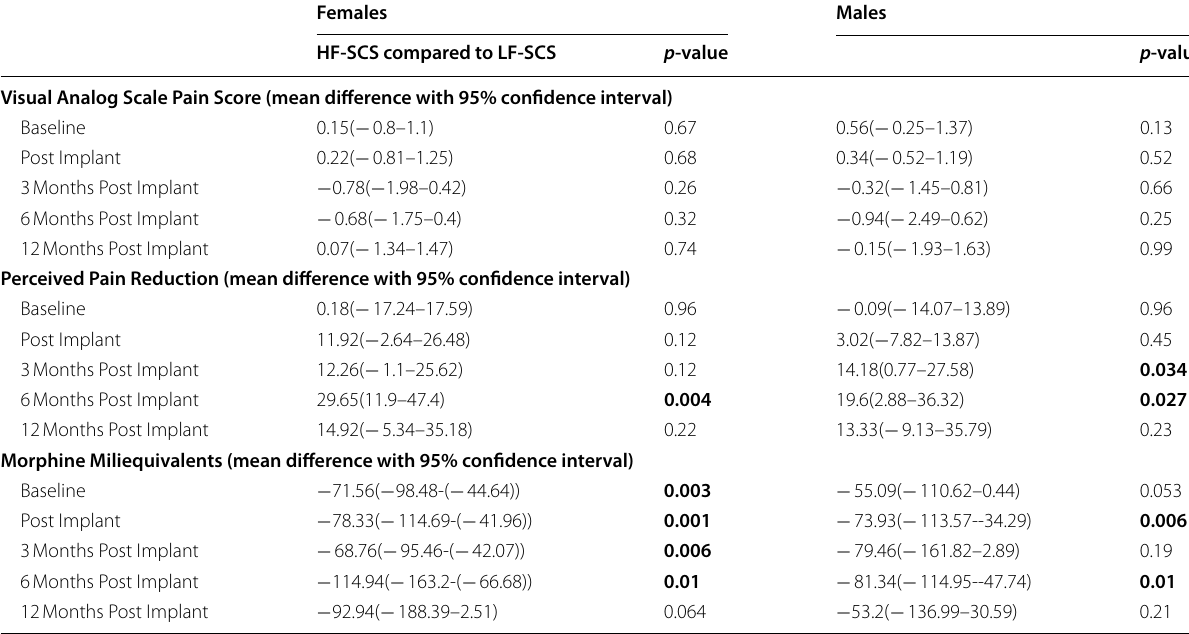
Table 6 Comparison of high frequency and low frequency spinal cord stimulator mean differences and 95% confidence intervals at each time point for visual analog scale pain scores, perceived pain reduction and opioid use according to sex. For mean differences, the confidence interval is considered not significant if it crosses